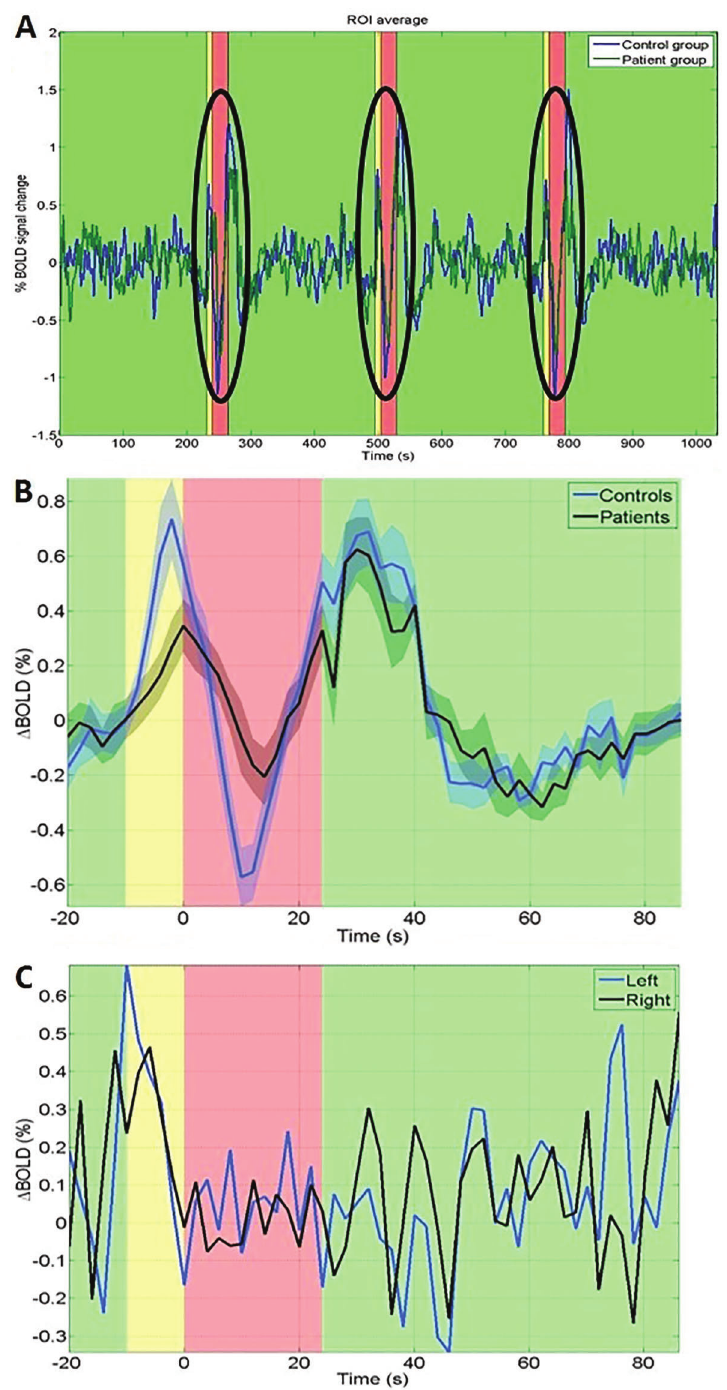
Figure 2. A , mean BOLD% signal variation in the time series during paradigm patients and controls. B , averaged delta BOLD% signal, which was signi fi cantly different between groups (P=0.032, Mann-Whitney test). C , visually different BOLD signal curves were observed in both left and right lentiform nucleus of the patient P12, who did not comply with the breath-holding test. In A , B and C , the background colors represent the paradigm tasks during the green (normal breathing), yellow (normal breathing in preparation for holding) and red screen (breath